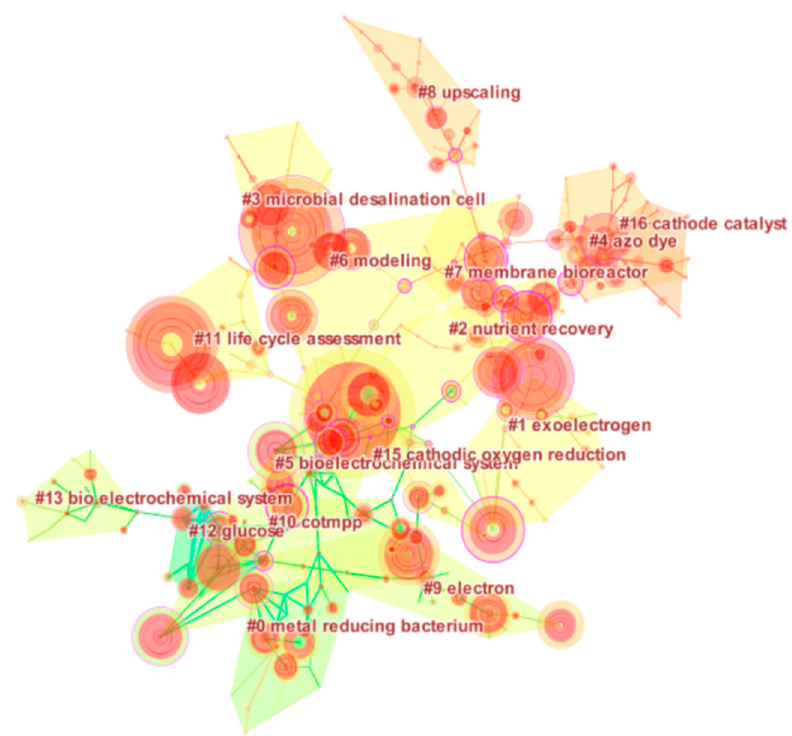
Figure 5. Cluster network on MFCs in wastewater treatment.